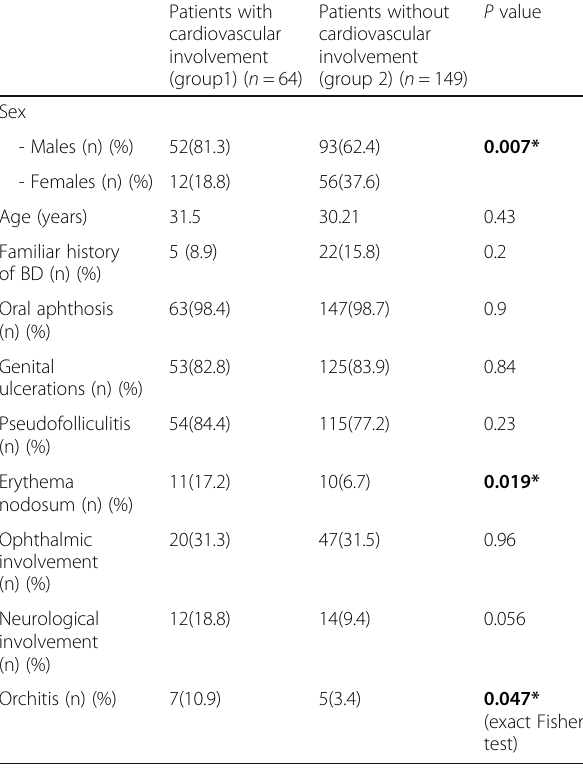
Table 2 cardiovascular features in Behçet Disease patients Cardiovascular features